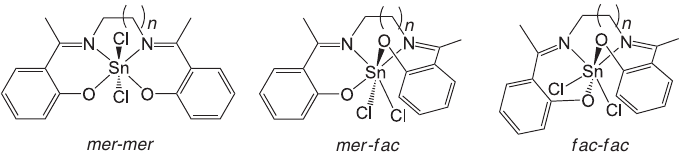
Figure 3 Molecular structures of (from left) the mer-mer , mer-fac and fac-fac isomer of L 1 SnCl optimized with Gaussian09 (Frisch et al., 2009) at the B3LYP (CHNOCl: 6-31G(d); Sn: SDD) level. For each row, the relative energies of the isomers (in kcal/mol) are given below the molecular structure. The relative energies in parentheses (also in kcal/mol) were obtained from single-point analyses at the MP2 (CHNOCl: 6-31G(d); Sn: SDD)